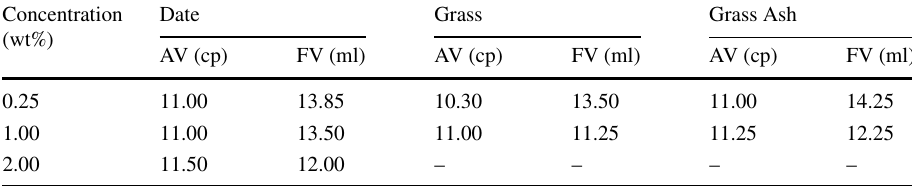
AV apparent viscosity, FV